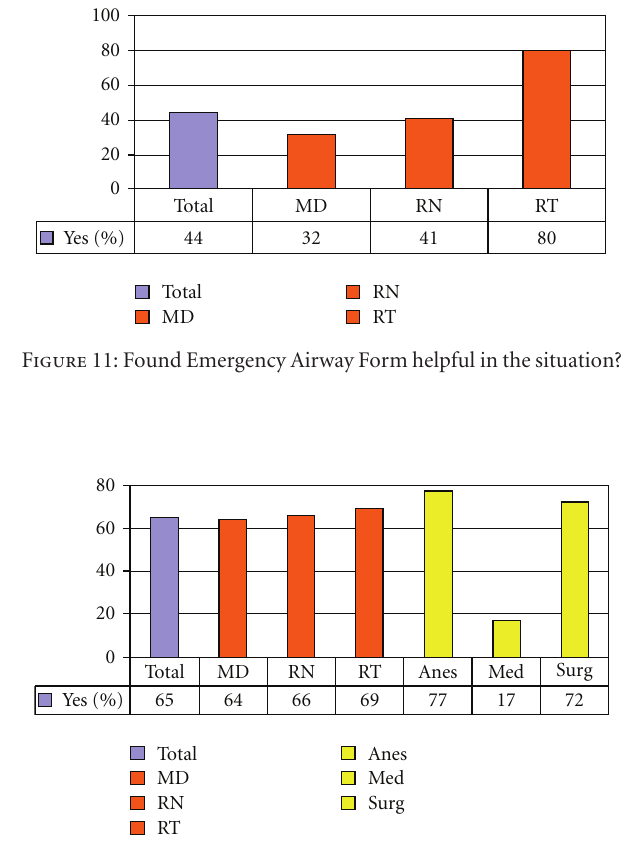
Figure 12: Received education/training on emergent airway situa- tions in last 12